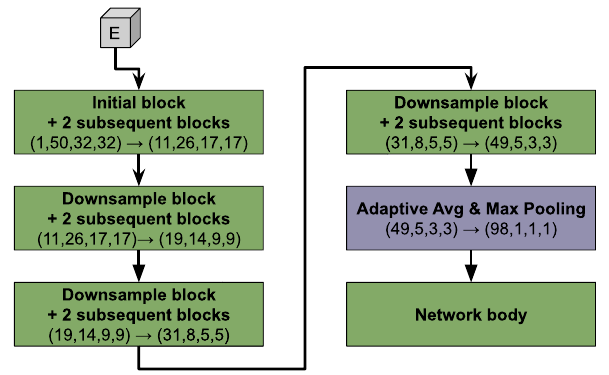
Fig. 5 Block layout for the convolutional head. Tensor dimensions are indicated in the form ( channel , z,x,y ) . The convention is to increase the number of channels to eight in the first downsample, and then increase the number of channels at each downsample by a factor of 1.5. The number of channels increases by one in each block due to the energy concatenation. Prior to being fed into the network body, the tensor is pooled by computing the maximum and mean of each channel. The data-batch dimension is not shown, for simplicity